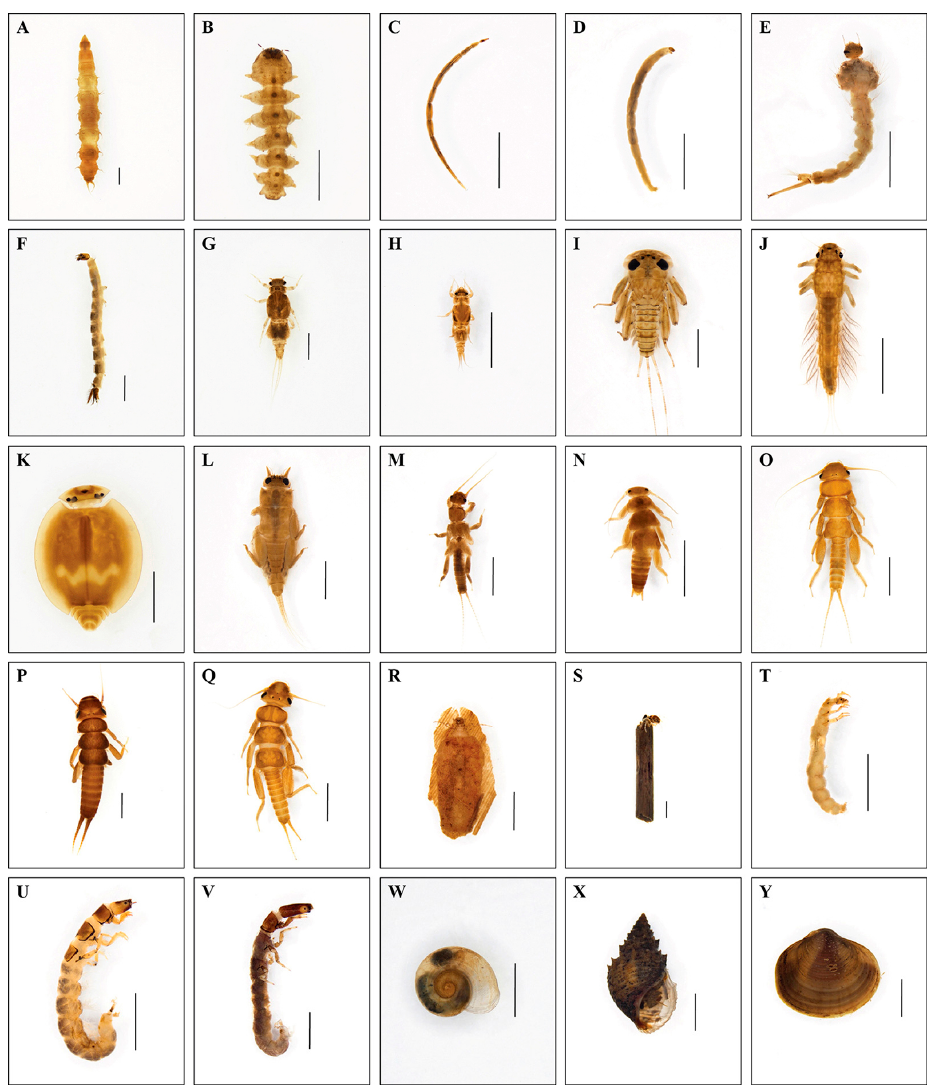
Figure 2. Benthic macroinvertebrates found in the study localities with their tolerance values. A-F Diptera: ( A ) Athericidae, Suragina , tolerance value three; ( B ) Blephariceridae, Blepharicera , tolerance value one; ( C ) Ceratopogonidae, Bezzia , tolerance value seven; ( D ) Chironomidae, tolerance value nine; ( E ) Culicidae, tolerance value nine; ( F ) Dixidae, tolerance value three: ( G – L ) Ephemeroptera: ( G ) Caenidae, Caenis , tolerance value seven; ( H ) Caenidae, Clypeocaenis , tolerance value seven; ( I ) Heptageniidae, Thalerosphyrus lamuriensis , tolerance value two; ( J ) Potamanthidae, Potamanthus formosus , tolerance value two; ( K ) Prosopistomatidae, Prosopistoma , tolerance value three; ( L ) Vietnamellidae, Vietnamella thani , tolerance value one: ( M – Q ) Plecoptera: ( M ) Nemouridae, Indonemoura , tolerance value one; ( N ) Peltoperlidae, Cryptoperla , tolerance value one; ( O ) Perlidae, Etrocorema , tolerance value three; ( P ) Perlidae, Phanoperla , tolerance value two; ( Q ) Perlidae, Togoperla , tolerance value three: ( R – V ) Trichoptera: ( R ) Calamoceratidae, Anisocentropus , tolerance value one; ( S ) Calamoceratidae, Ganonema , tolerance value one; ( T ) Glossosomatidae, Agapetus , tolerance value one; ( U ) Hydropsychidae, Cheumatopsyche , tolerance value seven; ( V ) Stenopsychidae, Stenopsyche , tolerance value three: ( W – X ) Mesogastropoda: ( W ) Planorbidae, Indoplanorbis exustus , tolerance value eight; ( X ) Thiaridae, Thiara scabra , tolerance value eight: ( Y ) Veneroida, Corbiculidae, Corbicula , tolerance value eight. Scale bars: 2 mm.